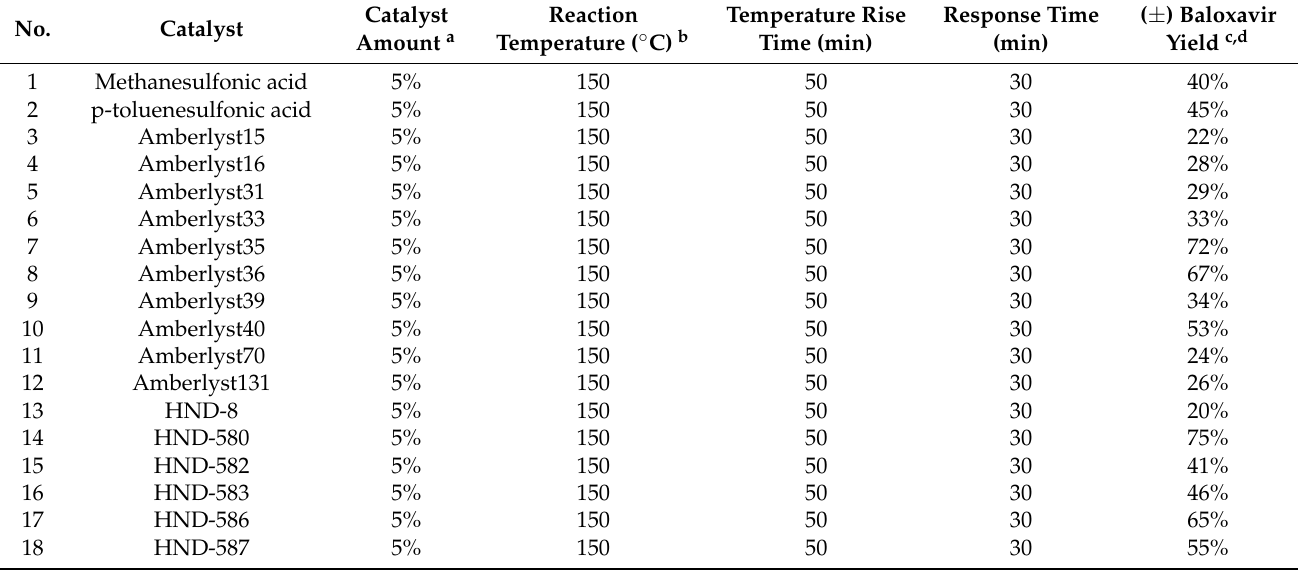
Table 1. Screening of